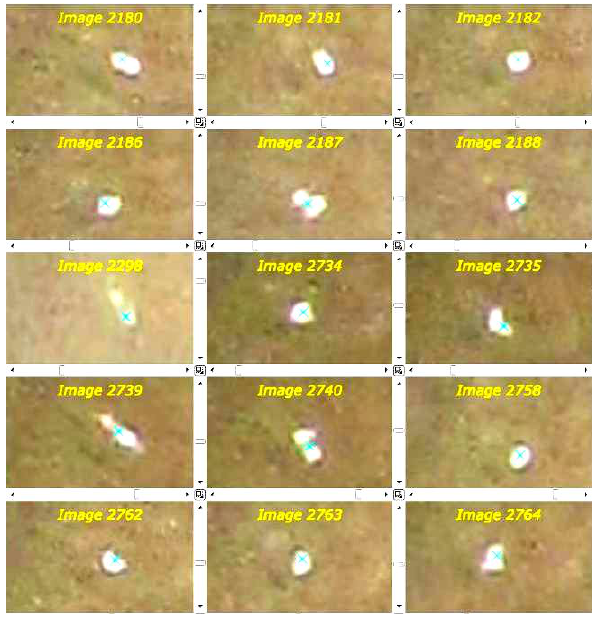
Figure 6: Ground control point #119 as imaged in some of the tied